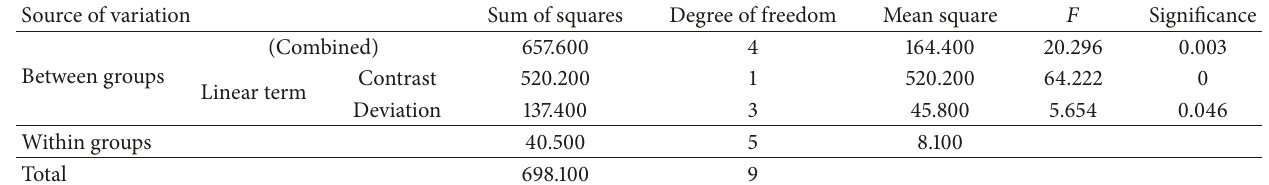
Table 7: ANOVA: single factor between the groups of different particle contents on rutting